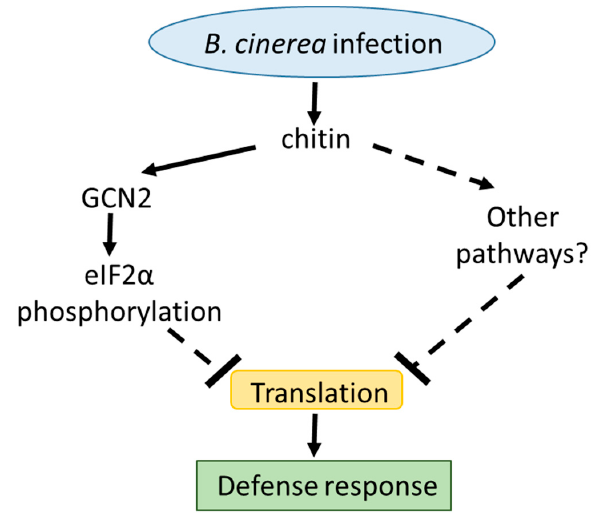
Figure 4. Proposed model for translation inhibition in response to chitin. Our results strongly suggest that chitin perception induces translation inhibition in plants. Chitin promotes, via activation of GCN2, the phosphorylation of eIF2 α . This mechanism may contribute, most probably in concert with others, to translation inhibition in response to this signaling molecule. This inhibition of translation, most probably along with the selective translation of proteins involved in coping with the stress, may contribute to the proper activation of plant defense. The main role of regulation of translation in plant immunity has also been highlighted by other authors such as [24,25]. Solid and dashed lines represent proven and unknown connections among the processes, respectively.